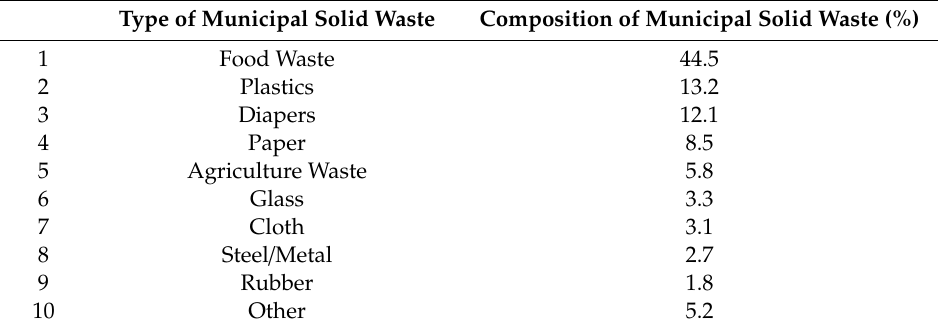
Table 4. Composition generation of MSW in Malaysia